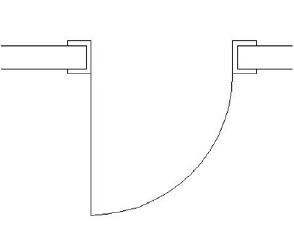
Figure 5. Symbology used to represent doors in a drawing